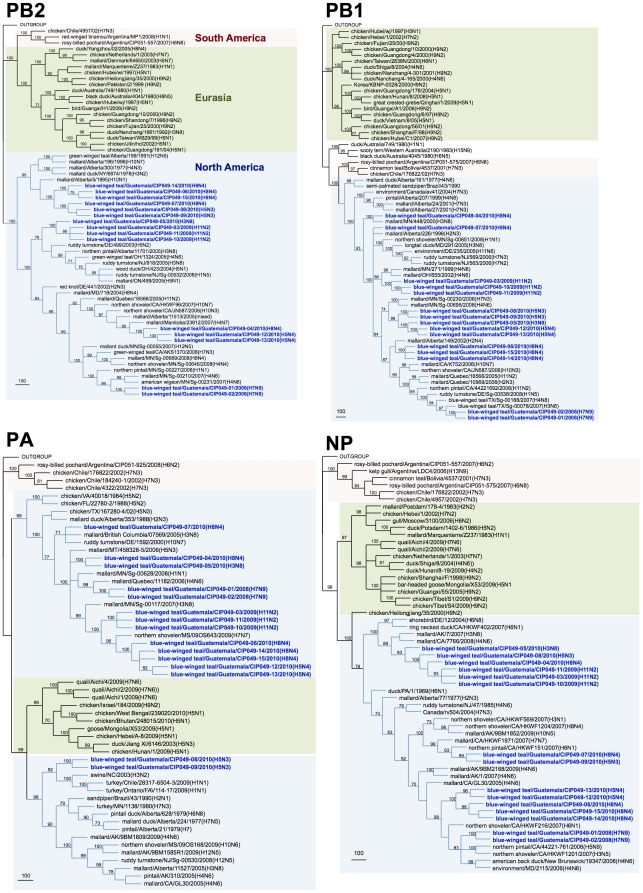
Phylogenetic trees for internal gene segments PB2, PB1, and PA.All trees were generated in PAUP 4.0b10 using Neighbor-Joining method with 1000 bootstrap replicates (bootstrap values above 70% are shown). Scale bar on the bottom-left indicates number of nucleotide substitutions per site.